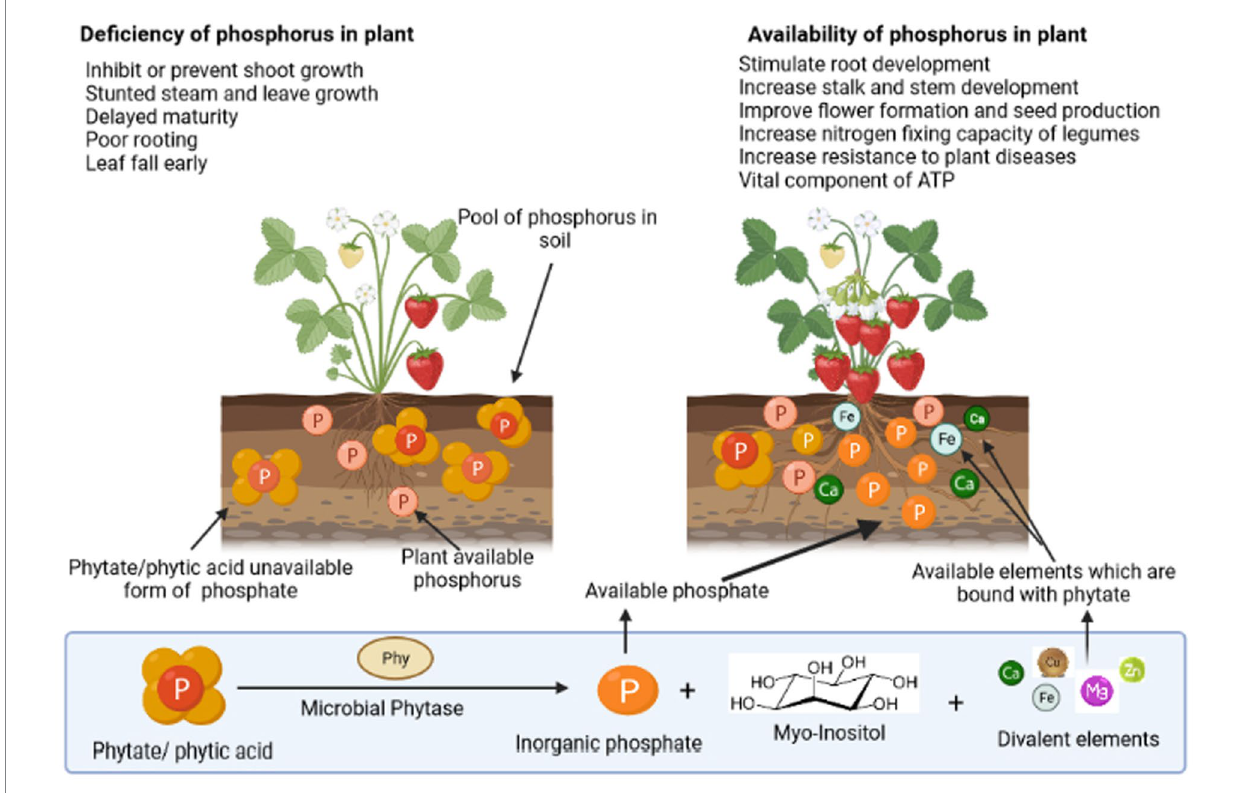
FIGURE 1 Depiction of the importance of phosphorus to a plant and the role of phosphate solubilizing microorganisms in the utilization of different forms of phosphorus via diverse